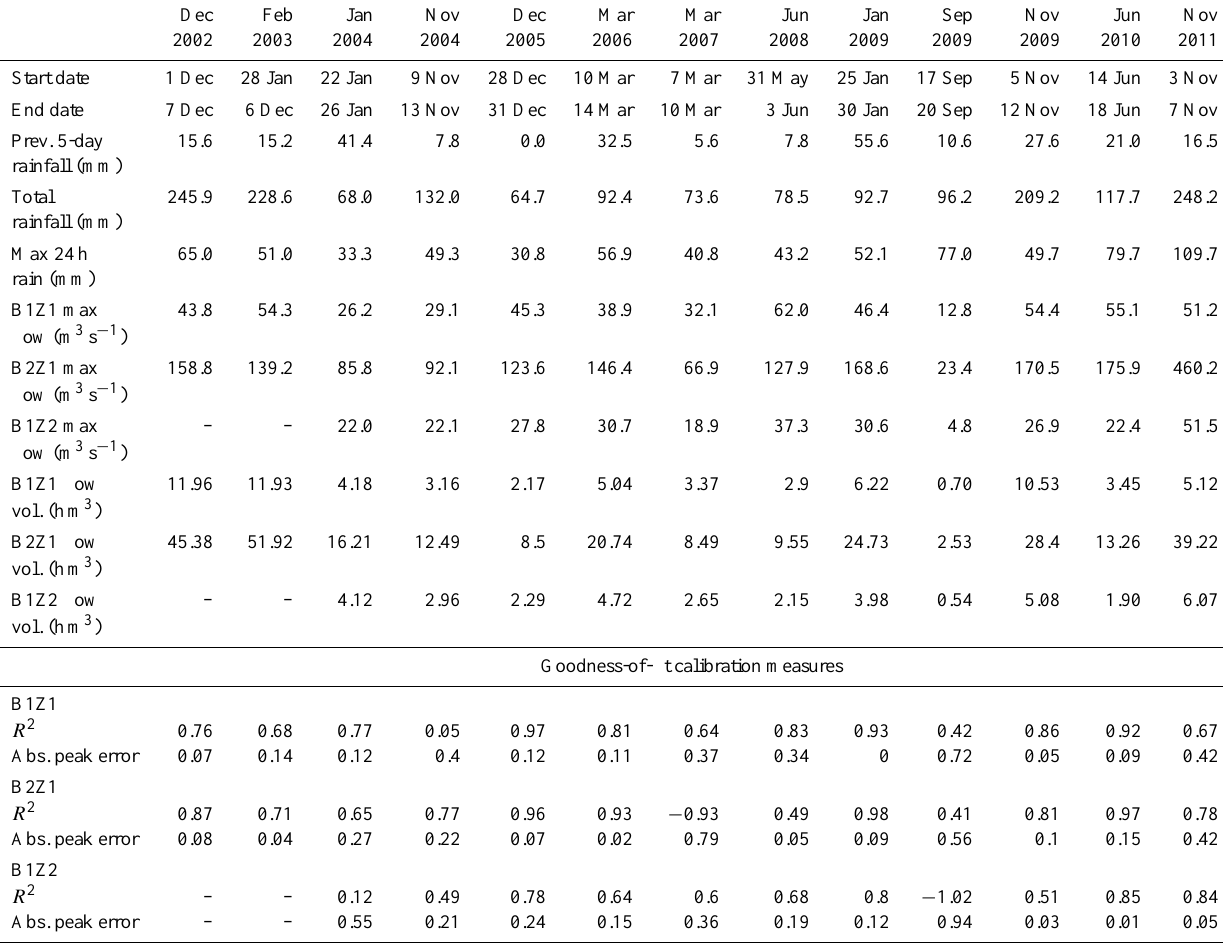
Table 6. Summary of event calibration data for the TETIS model.